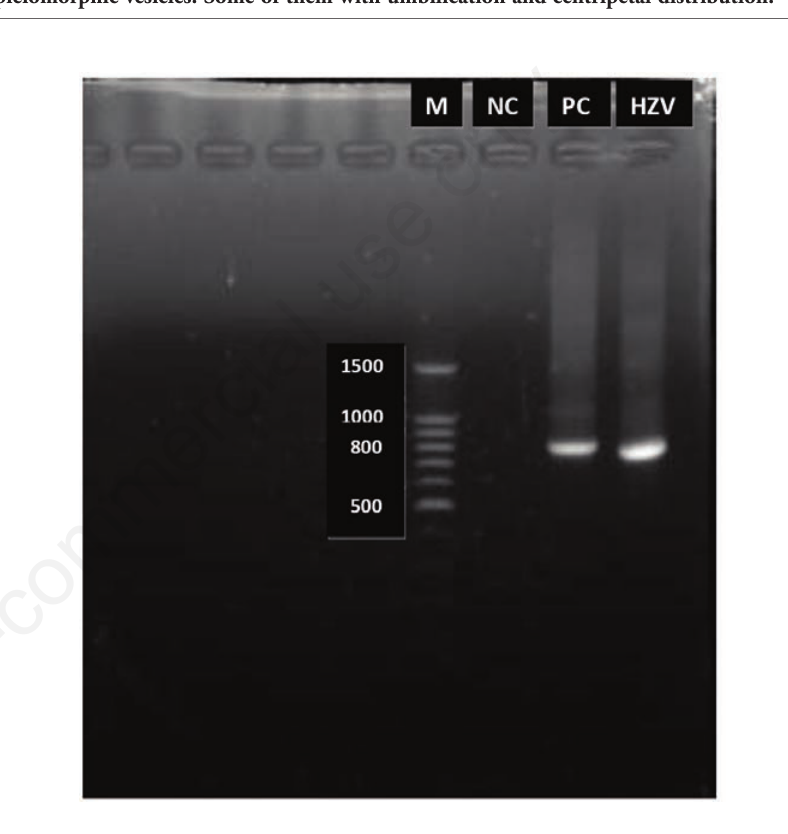
Figure 2. This electrophoresis shows amplicon if 810 bp. M: marker (100 BP DNA lad- der); NC: negative control; PC: positive control; HZV, patient sample